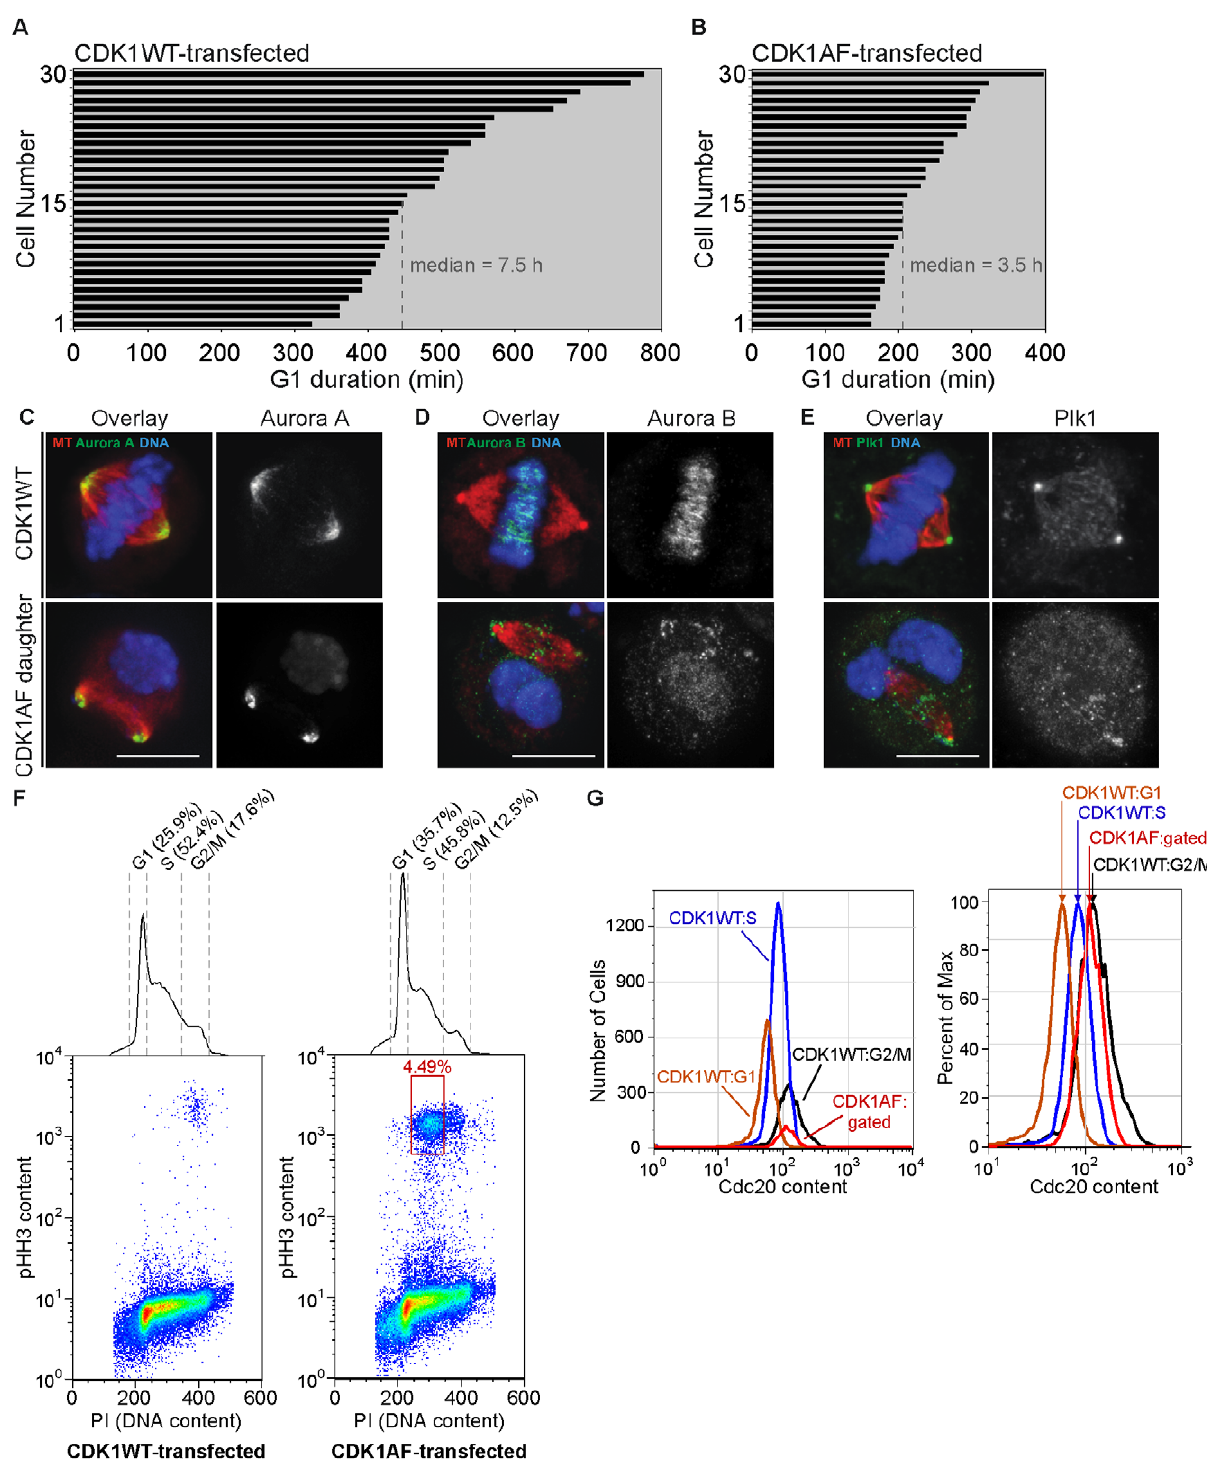
Figure 1. M-phase kinases are present and properly localized on mitotic spindles formed in G1 daughters with impaired APC-Cdh1 activity. (A) Histogram of G1-phase duration in daughters of CDK1WT-expressing HeLa cells. (B) Histogram of G1-phase duration in daughters of CDK1AF-expressing HeLa cells. (C) CDK1WT M-phase cell and M-phase-like G1 cell (CDK1AF daughter) probed for Aurora A, (D) Aurora B, and (E) Plk1; mCherry- a -tubulin (red) and kinases (green). (F) Pseudo-color scatter plots of DNA content vs. phospho-histone H3 (pHH3) content in 50000 CDK1WT- transfected (left) or CDK1AF-transfected (right) HeLa cells, with DNA content histogram. (G) Histogram of Cdc20 contents in cell cycle phases of CDK1WT-expressing cells and the low DNA-content/high pHH3-content CDK1AF-expressing cells (left); same histogram shown as percent of max (right).